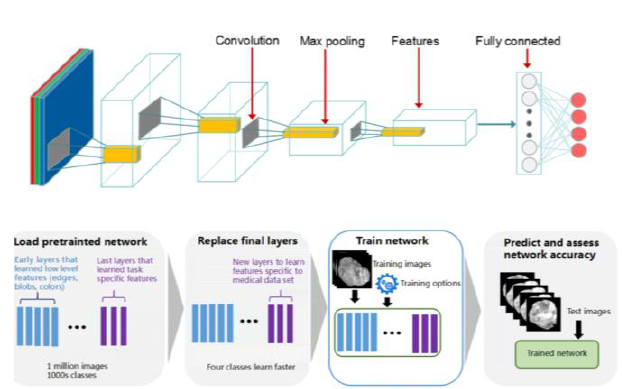
Figure 3.4: CNN Layered Classification [5]